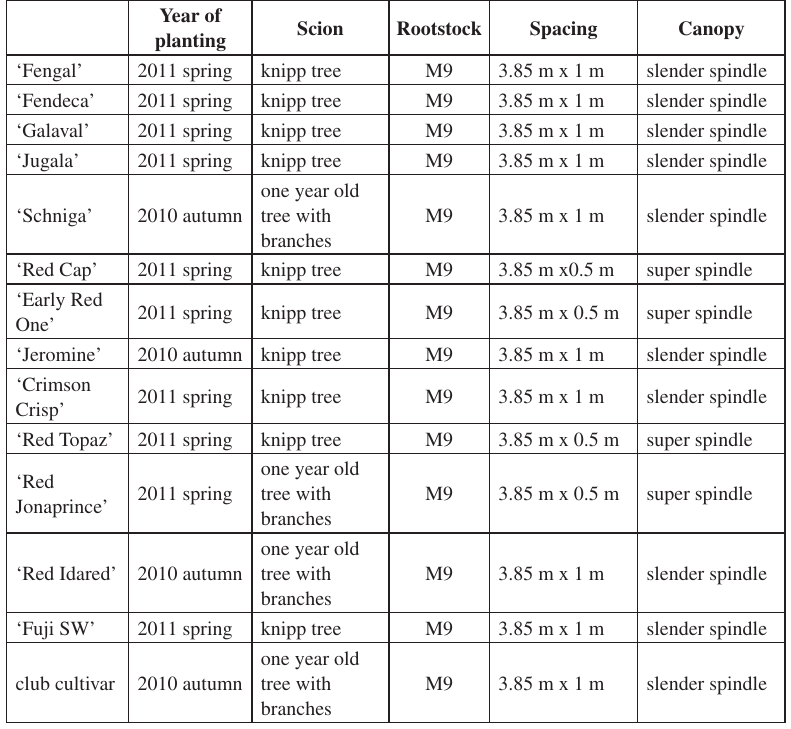
Table 2: The planting design of the examined apple